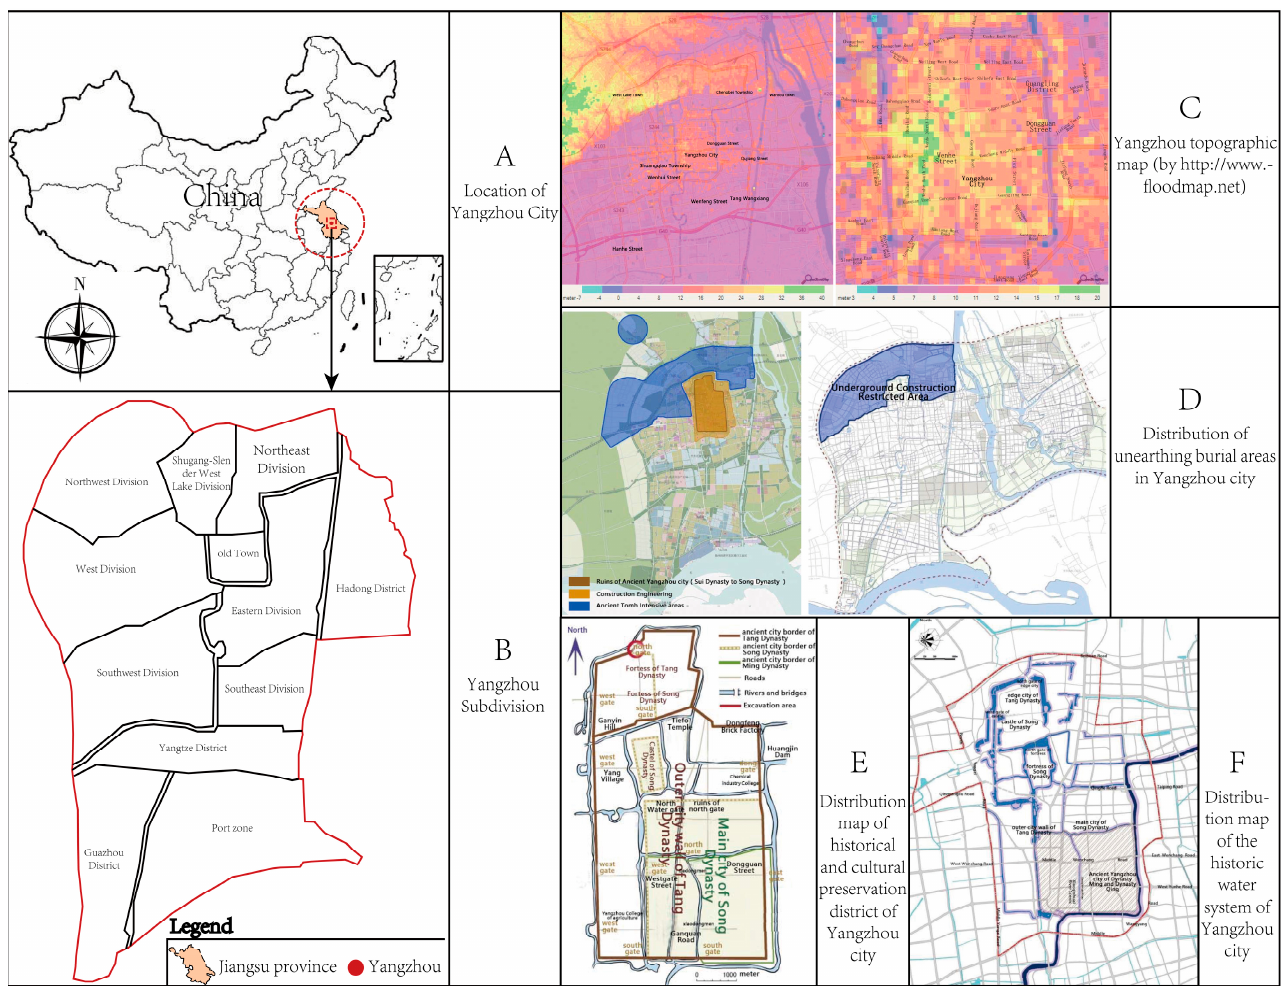
Figure 1. Basic information map of Yangzhou’s geographic location and current situation.